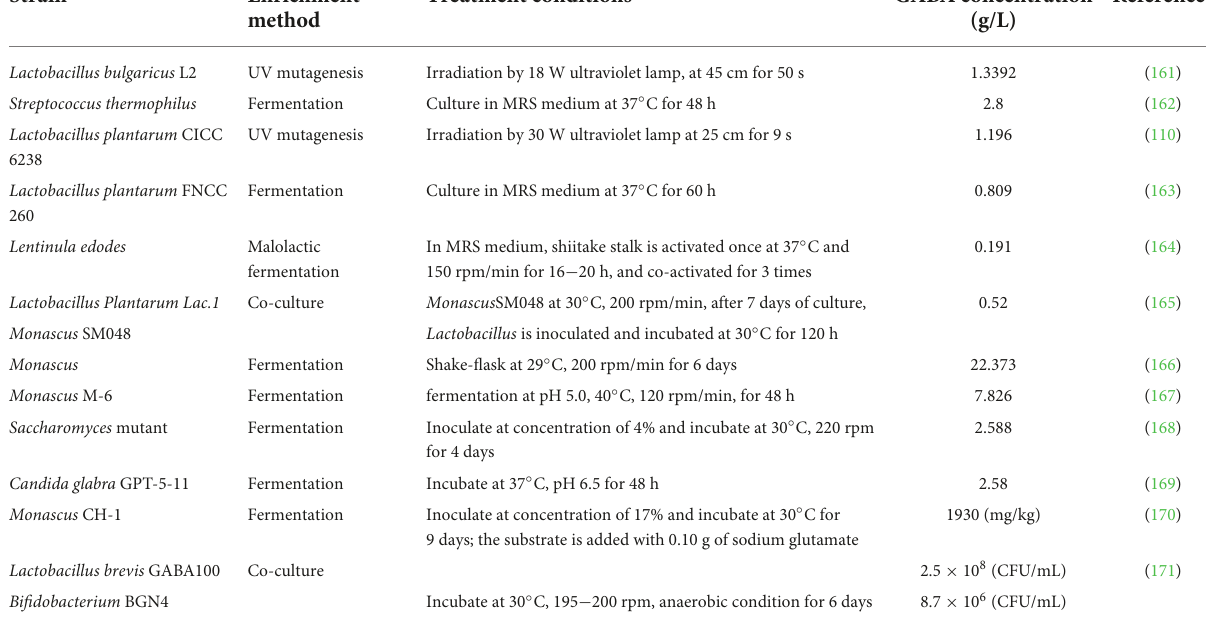
TABLE 4 Enrichment of GABA by microbial